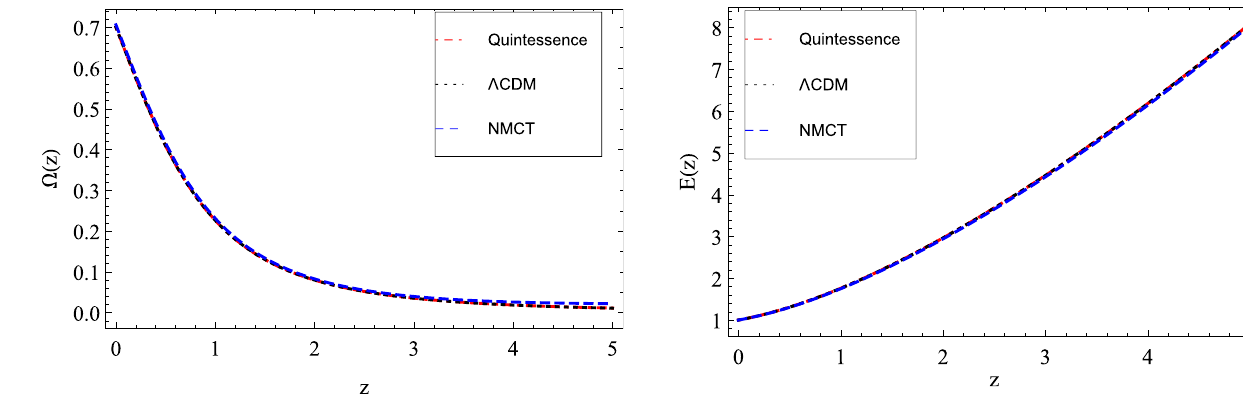
Fig. 3 The variations of the dimensionless Hubble parameter with respect to the redshift for the quintessence, minimally-coupled tachyon and the standard cosmological